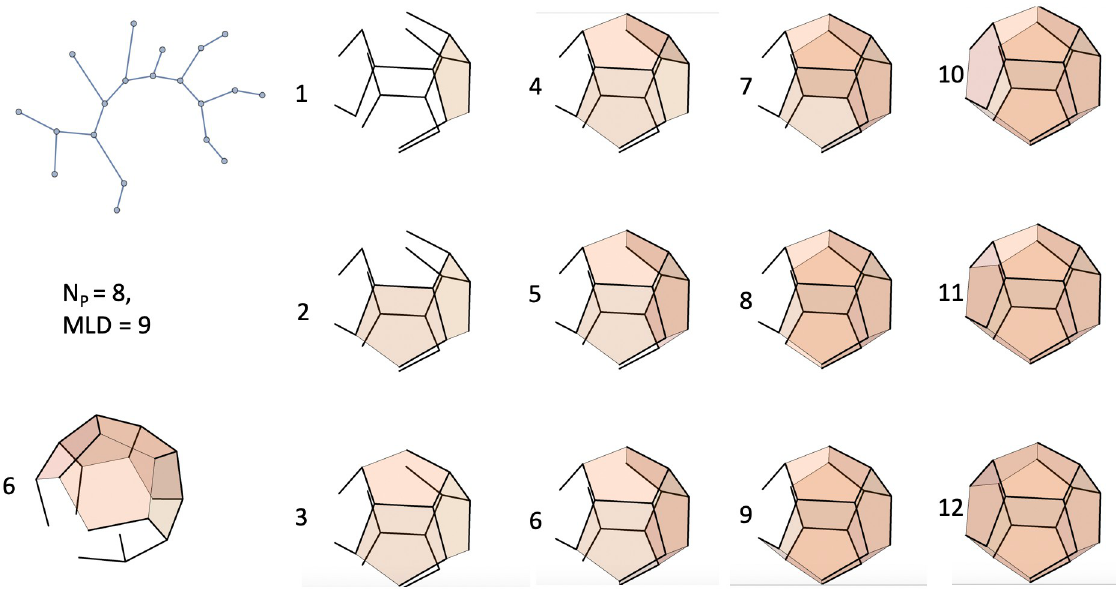
Fig 5. A spanning tree with a maximum wrapping number of eight and the minimum MLD of nine. The first five pentamers can be placed on sites that maximize both the number of available pentamer-pentamer contacts and pentamer-spanning tree link contacts (four). The sixth pentamer, shown separately with a different perspective, makes three pentamer-pentamer contacts but can only make two spanning tree link contacts.